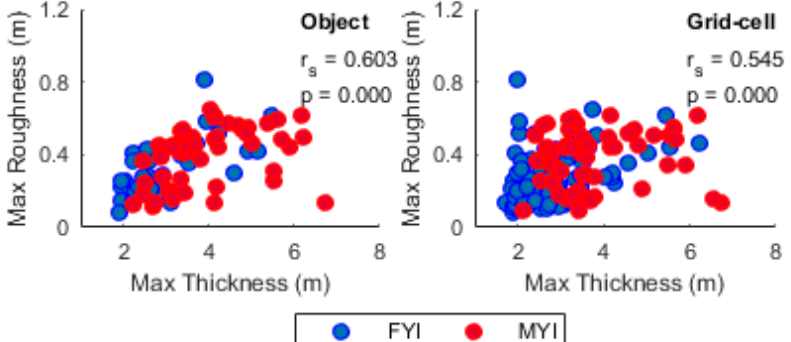
Figure 12. Scatter plots of maximum roughness as a function of maximum thickness at the medium scale using object ( left ) and 240 m grid-cell ( right ) aggregation approaches. Spearman correlation coefficients (r s ) and corresponding p -values are shown for pooled FYI and MYI data. The blue points correspond to first-year ice (FYI) and red points to multiyear (MYI); however, a typo was made in the legends. This correction will not change the results or any statements in the paper. The authors apologize for any inconvenience caused for readers.